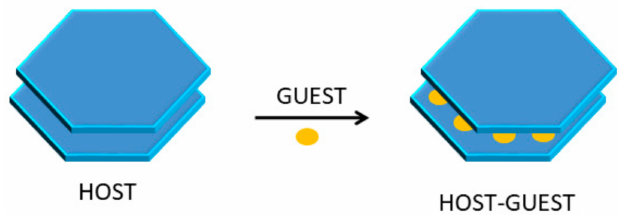
Figure 1. Scheme of an intercalation